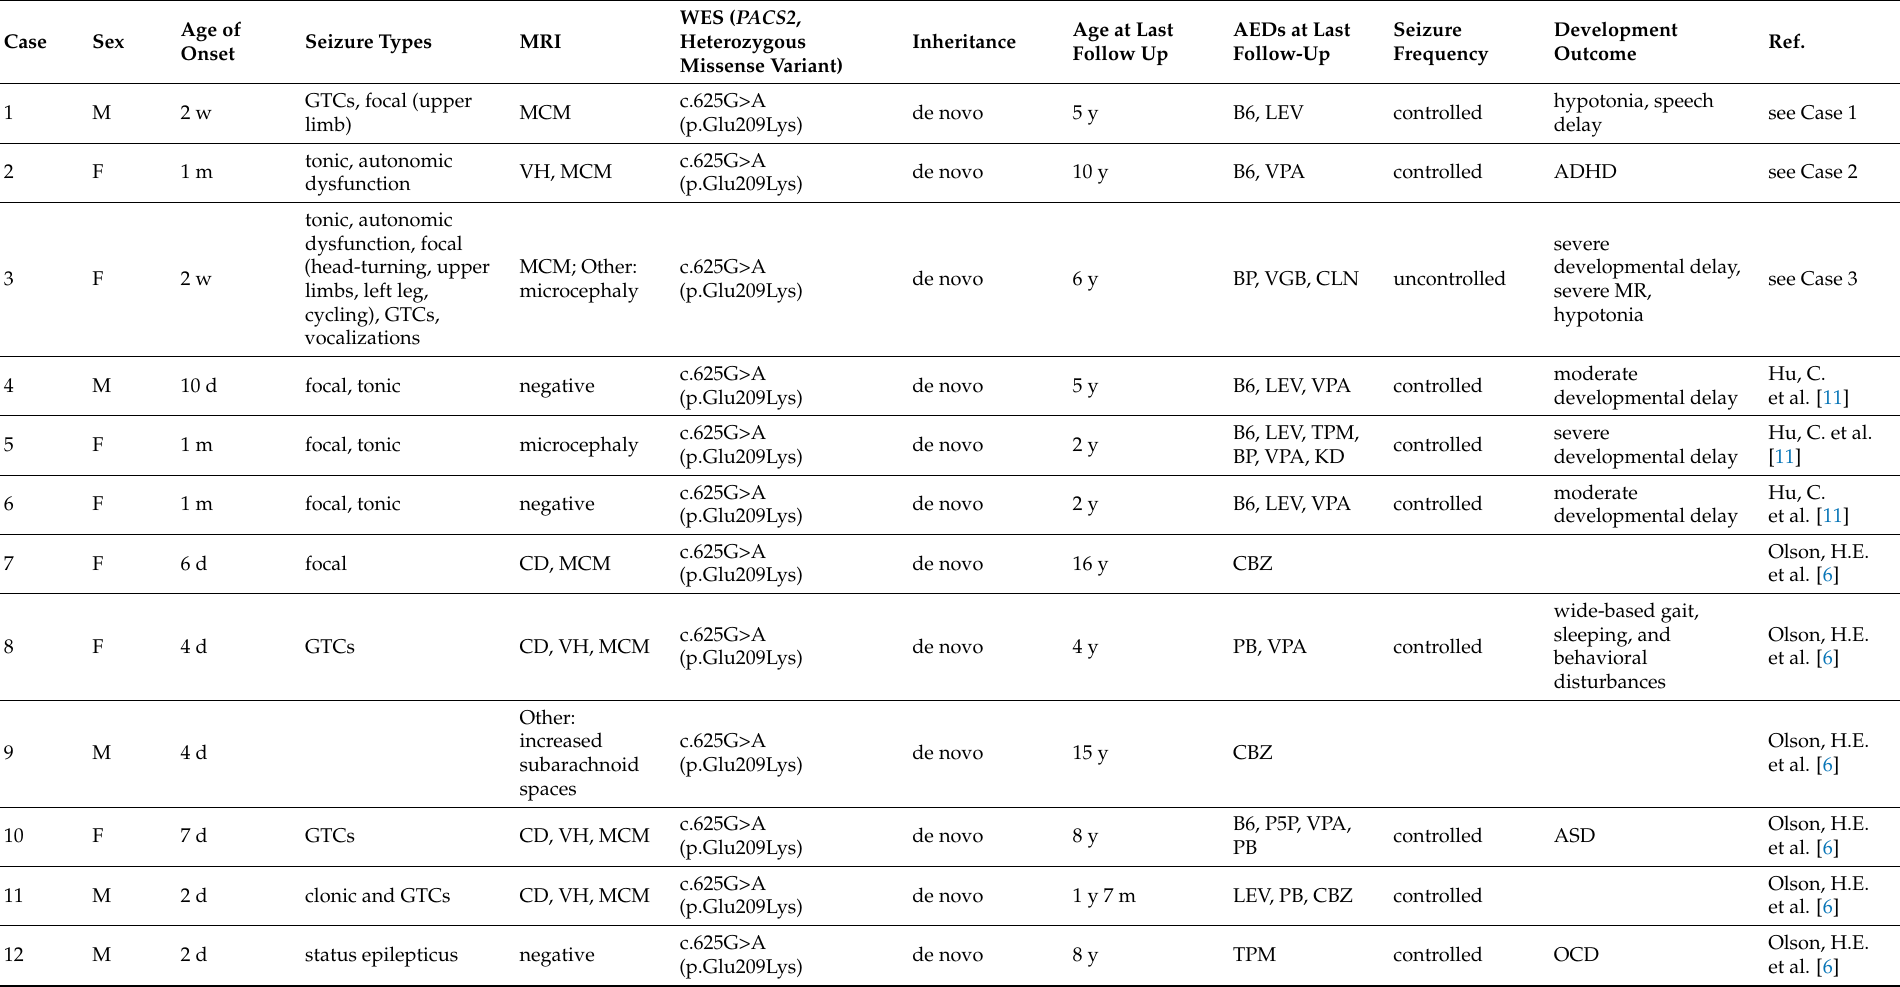
Table 1. Summary of the clinical phenotypic features in 32 patients with PACS2-related early infantile developmental and epileptic encephalopathy